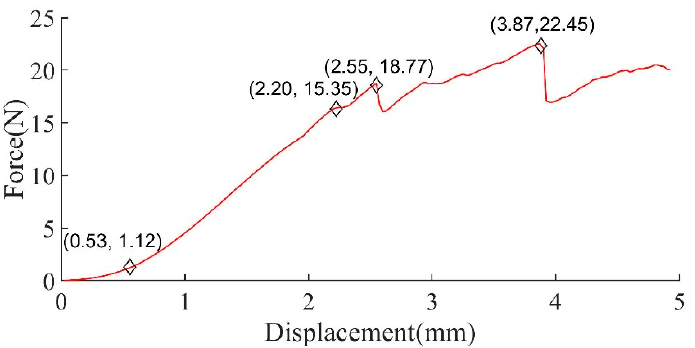
Figure 19. Force–displacement curve of the apple samples.